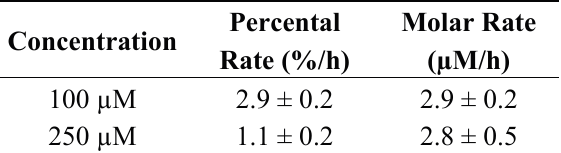
Figure 3. Percentage of liposomes taken up after incubation with 100 µM (solid symbols) and 250 µM (open symbols) of cBSA-liposomes for different timeframes. Values are the means of 3 separate experiments ± standard deviation ( n = 8, each). Table 2. Percental and molar uptake rates for 100 und 250 µM cationized bovine serum albumin (cBSA)-liposomes. Values and errors are determined by linear